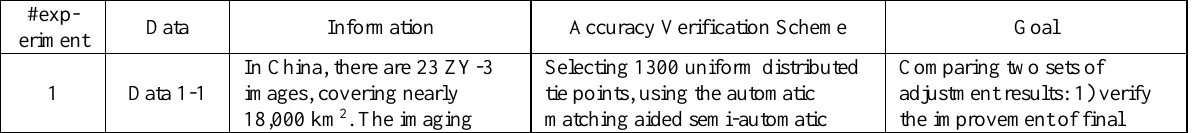
Table 1: description and scheme of different data sets for